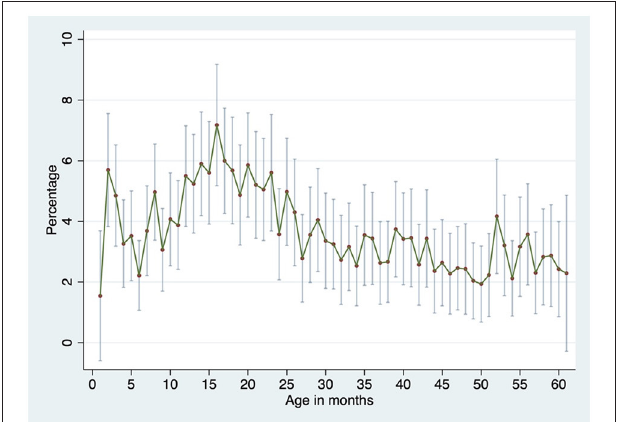
FIGURE 8 | Prevalence of wasting and stunting concurrence over children’s age in 2019. Source: Own elaboration based on Caritas Venezuela data. 95% confidence intervals. Stunitng and wasting were defined according to the 2006 WHO growth